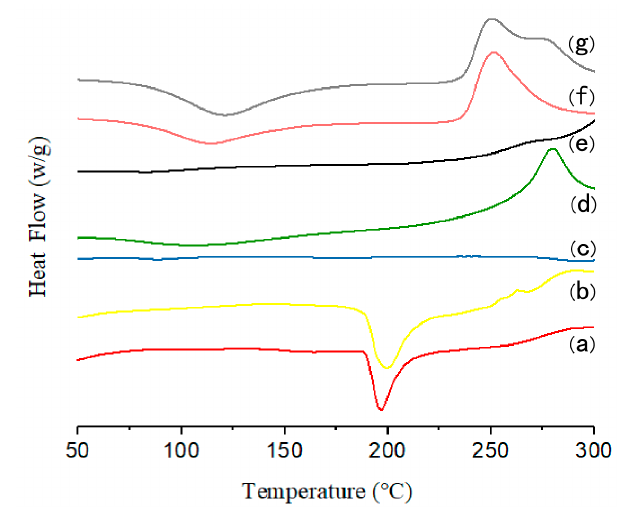
Figure 3. Differential scanning calorimetry (DSC) thermograms of ( a ) gefitinib crystals, ( b ) physical mixture of gefitinib and P407/PLGA NPs, ( c ) GFB/P407/PLGA NPs, ( d ) FA-conjugated CS, ( e ) GFB/FCPP NPs, ( f ) carboxymethyl β -glucan, and ( g ) GFB/FCPP-NEMs.